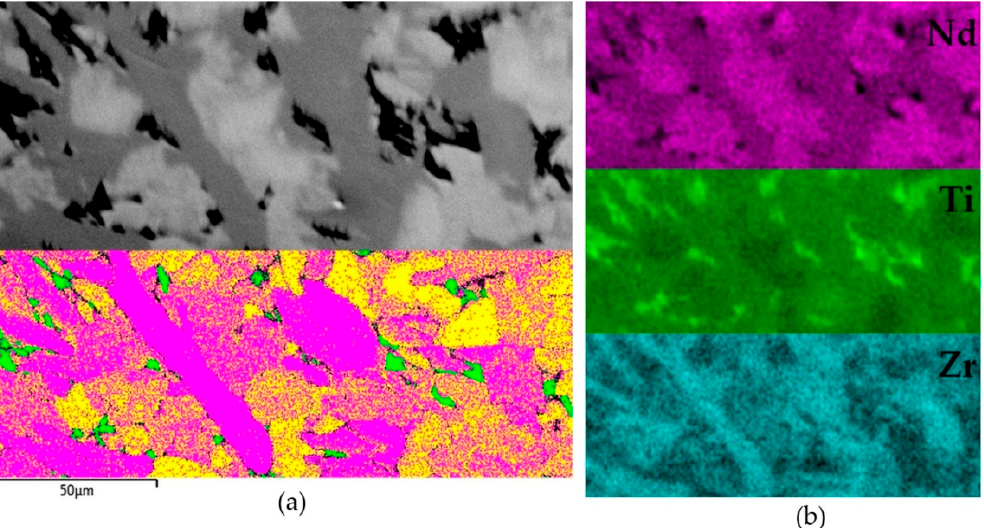
Figure 10. The structure of sample “Nd”: ( a ) top—BSE image (light—pyrochlore, gray—zirconolite, dark—rutile), bottom—EBSD map (yellow—pyrochlore, violet—zirconolite-4M, green—rutile); ( b ) distribution of Nd, Ti, Zr within the sample.